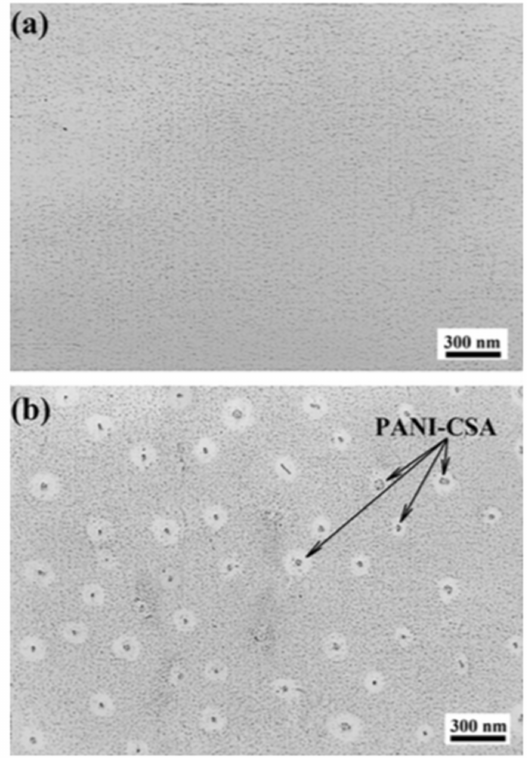
Figure 9. TEM images of ( a ) epoxy and ( b ) epoxy / polyaniline–camphor sulfonate (PANI-CSA) nanocomposite coatings. Reproduced from [79], with permission from Elsevier,